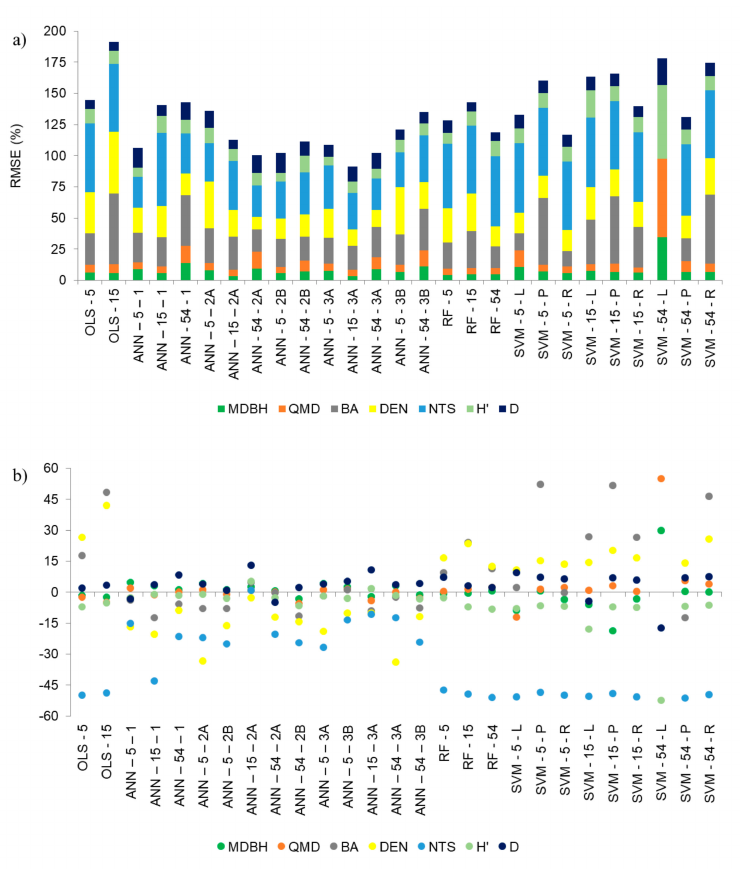
Figure 5. ( a ) RMSE in percentage for the regression methods tested for the seven estimated forest variables; ( b ) Bias in the percentage of each modeled variable for each regression method